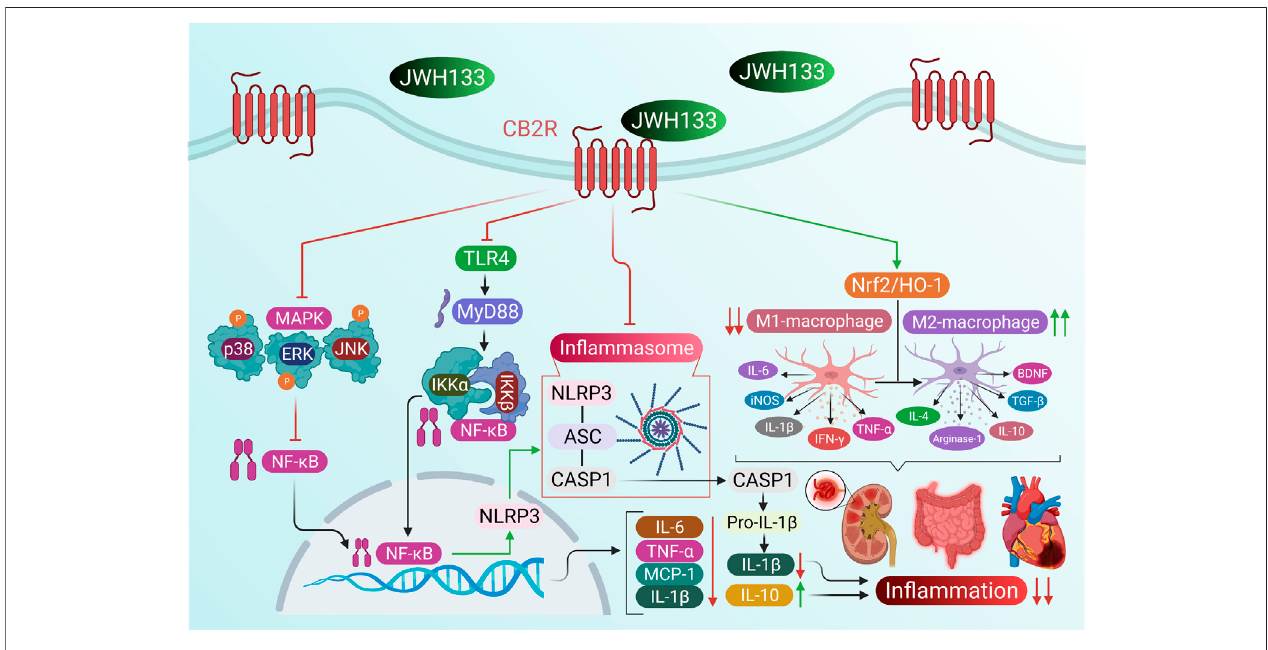
FIGURE 2 | The anti-in fl ammatory activity and mechanisms of